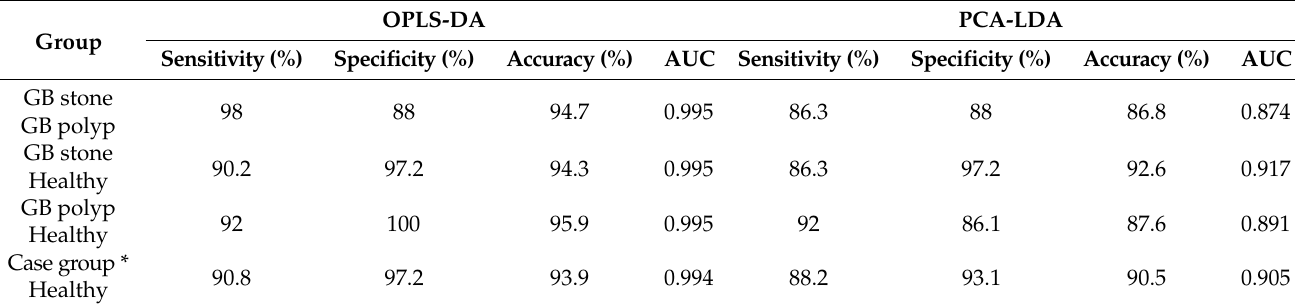
Table 4. The results of binary classification confusion matrix based on OPLS-DA and PCA-LDA analysis. OPLS-DA Group